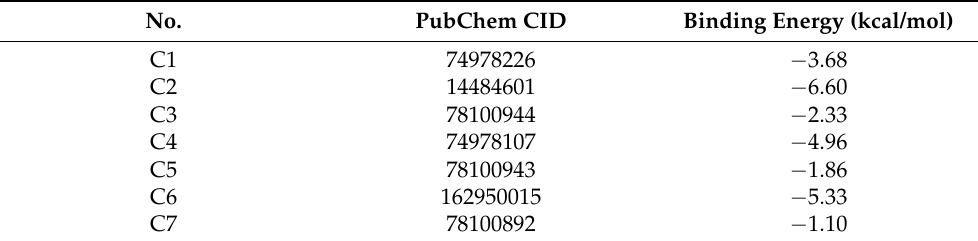
Table 3. Docking results between the main compounds in S. ternatum and IL-6.